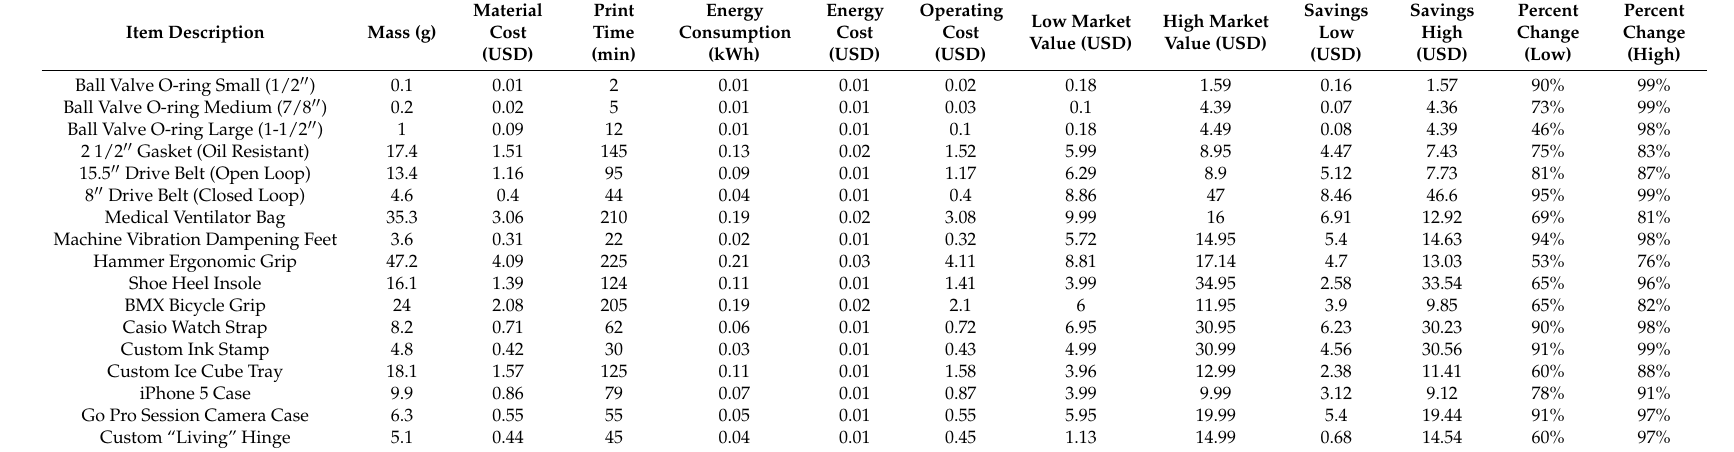
Table 3. Flexible 3-D Printed Objects, Material Cost, Print time, Energy Cost, Market Values, Savings and Percentage Change.